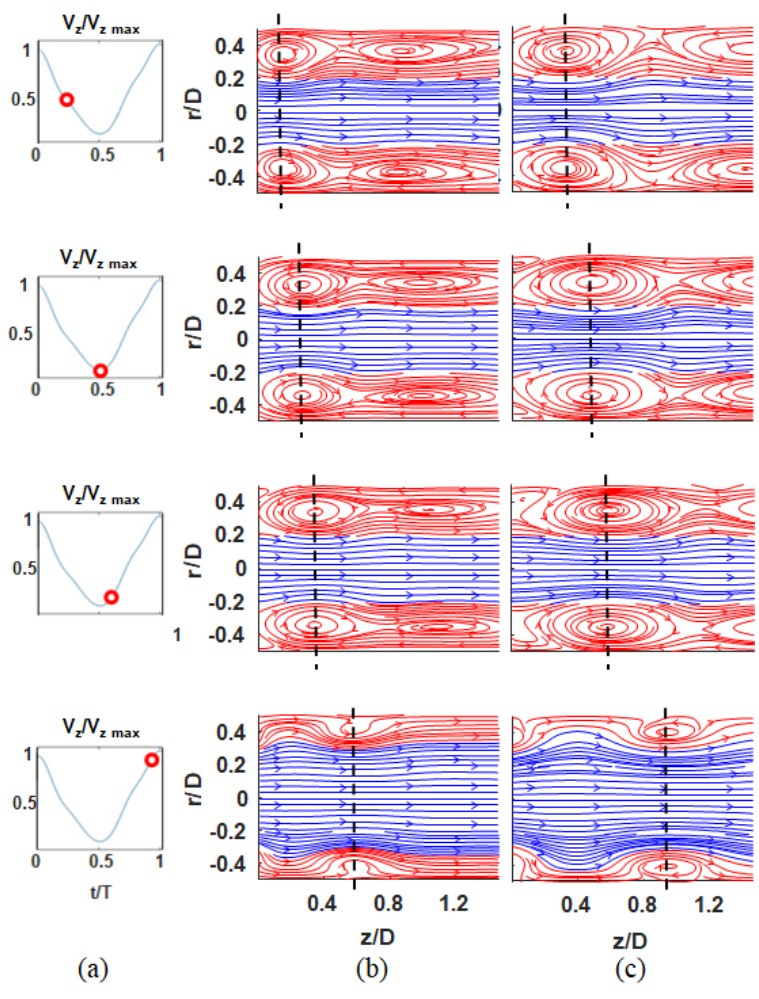
Figure 9: (a) Axial velocity profile at z = 0 and r = 0 and time at which the velocity field was obtained (red circles); (b) streamlines derived from simulation results for ¯ Re = 654; (c) streamlines derived from simulation results for ¯ Re = 1106. In both cases, red streamlines represent the central jet layer and blue streamlines represent the central jet (colours available online